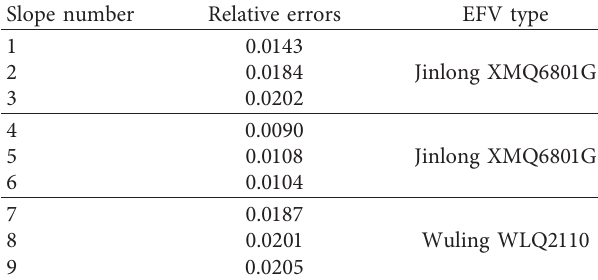
Figure 6: The results of model validation. (a) Slope 1. (b) Slope 2. (c) Slope 3. (d) Slope 4. (e) Slope 5. (f) Slope 6. (g) Slope 7. (h) Slope 8. (i) Slope 9. Table 5: The relative errors between theoretical values and col- lected values.